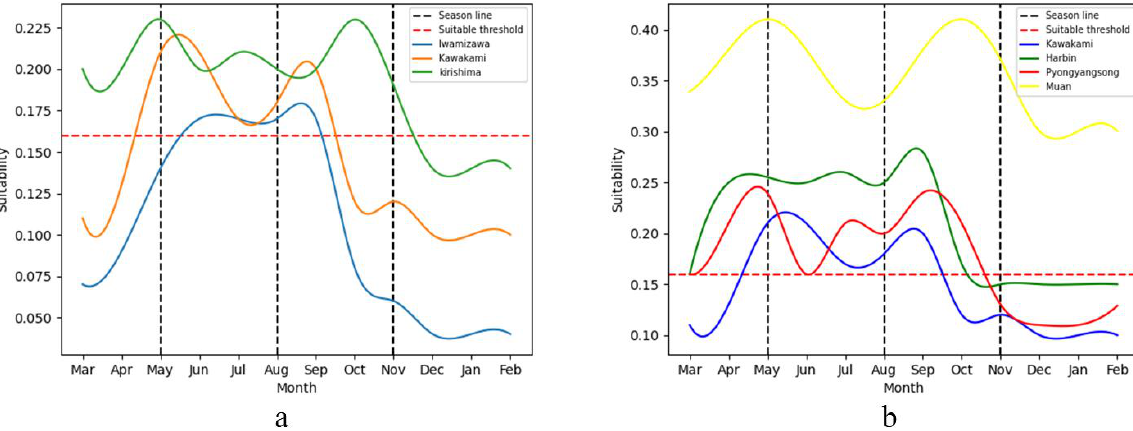
Figure 12. Monthly suitability comparison analysis ( a ) within Japan in 2020 and ( b ) within East Asia in 2020.